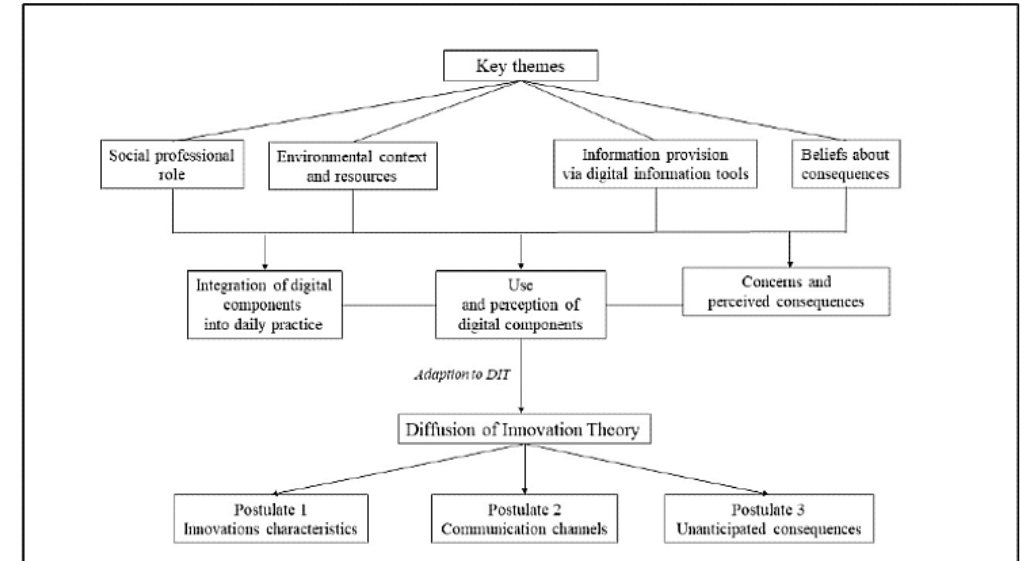
Figure 3. Theorizing analysis approach of the study. DIT: Diffusion of Innovations theory.